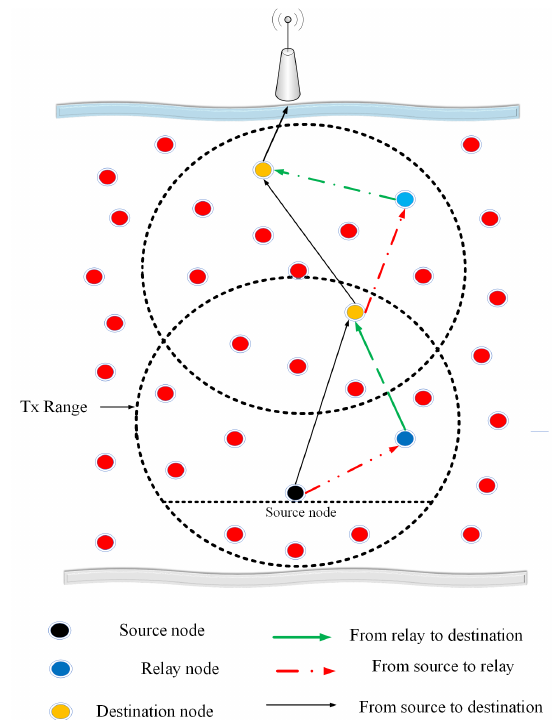
Figure 7. Cooperation